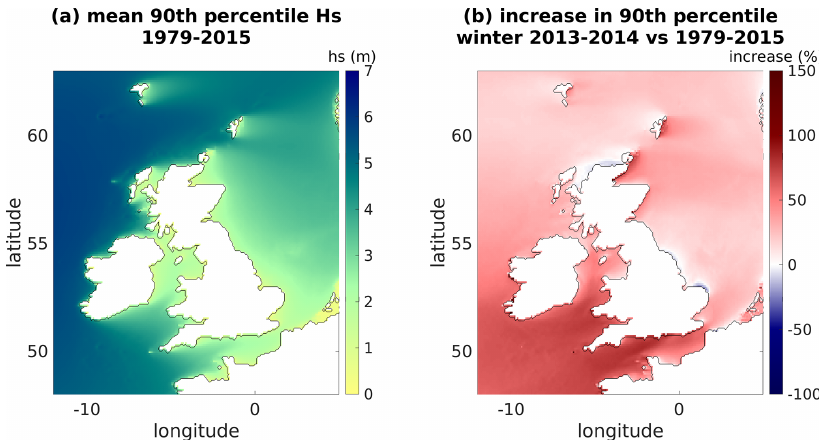
Figure 3. Mean of the H s ’s 90th percentile from the climatology run (a) . Percentage increase in H s in winter 2013/4 compared to climatology (1979–2015) derived from WW3 simulation (b) . Note the skewed colour range and that in some areas of the UK east coast and north of Scotland the H s in Fig. 3 does